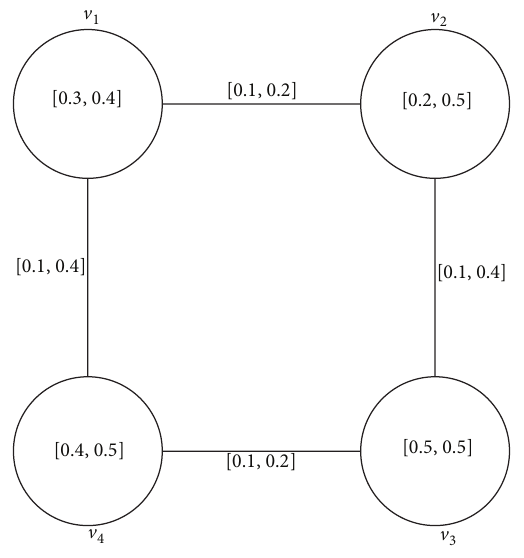
Figure 7: 𝐺 is neighbourly irregular but not highly irregular.